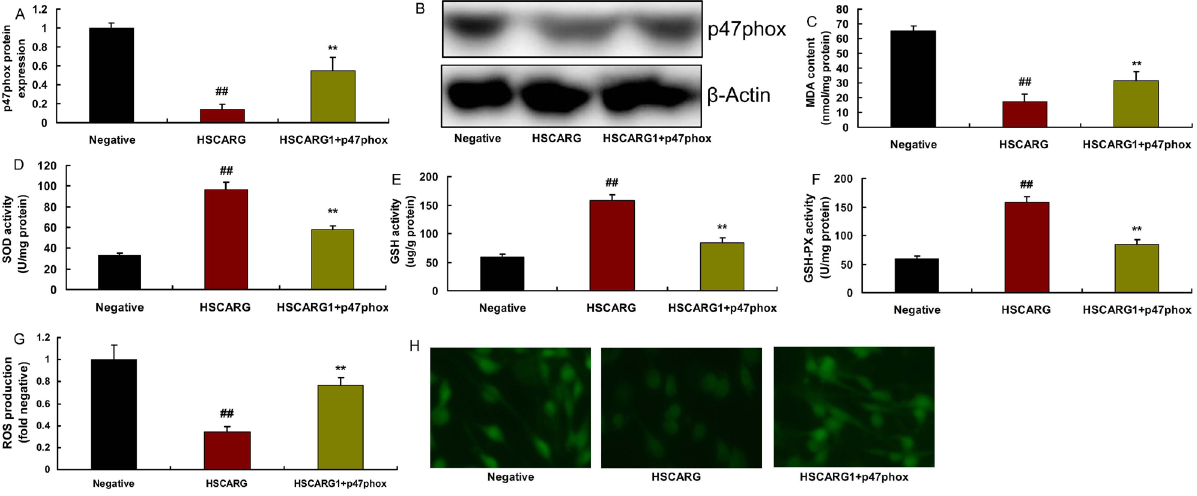
Fig. 8 - Overexpression of p47phox in the effects of HSCARG in coronary heart disease. 47phox protein expression (A and B), malondialdehyde (MDA) (C), superoxide dismutase (SOD), glutathione peroxidase (GSH-PX), and glutathione (GSH) levels (D, E, and F), reactive oxygen species (ROS) production levels (G and H). Negative=negative mimic group; HSCARG=overexpression of HSCARG group; HSCARG+p47phox=overexpression of HSCARG and p47phox group. ##P<0.01 compared with negative mimic group; **P<0.01 compared with overexpression of HSCARG